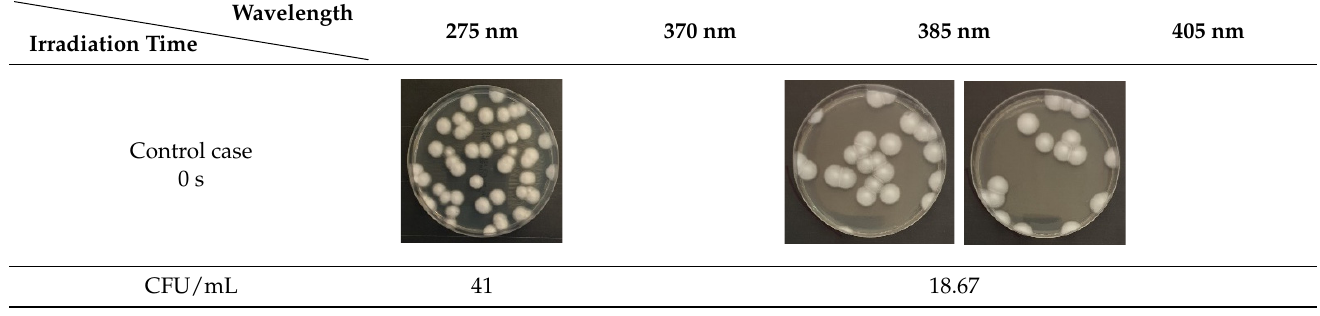
Table 6. Numbers of P. chrysogenum colonies by wavelength and irradiation time.